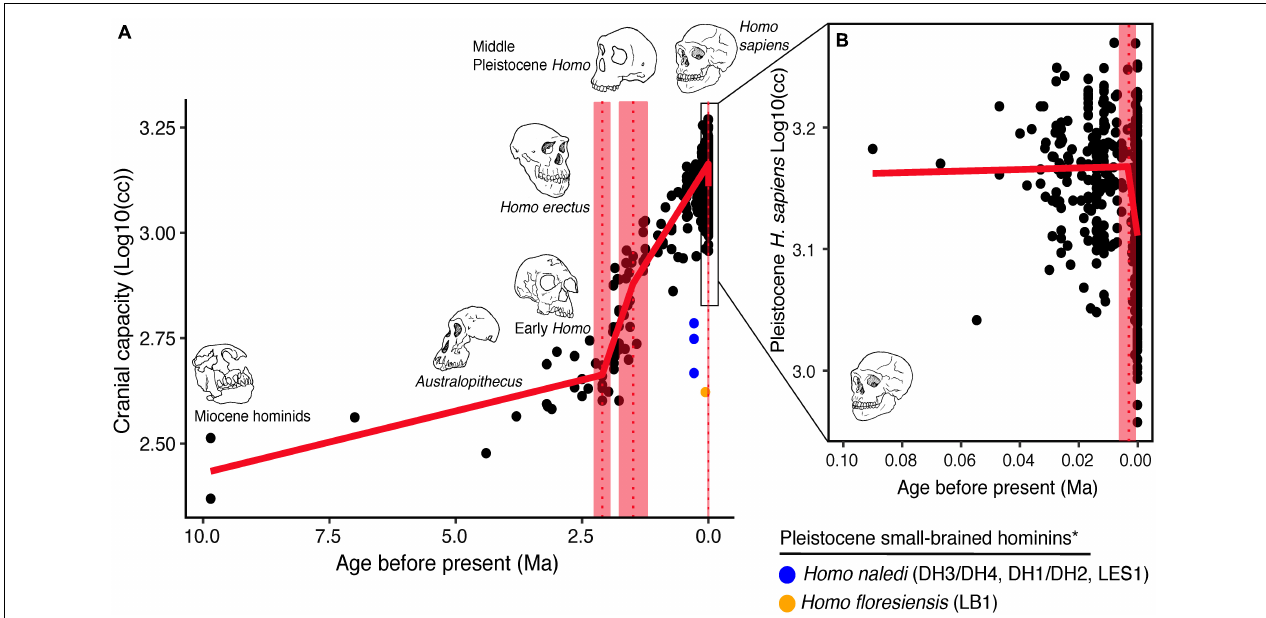
FIGURE 1 | Trends in hominin brain evolution. (A) Cranial capacity in fossil apes (Miocene hominids) and hominins over the last 10 million years. Brain size remained relatively steady throughout the late Miocene and Pliocene, increasing only slightly in Australopithecus compared with earlier hominins. However, by 2 million years ago, there was a dramatic increase in the rate of growth, coinciding with fossil evidence for the earliest members of genus Homo . This change point is illustrated by a red vertical dotted line (95% CI shown as thick pink vertical line). A second change-point is detected at ∼ 1.5 million years ago and the rate of brain size increase remains steady through the Pleistocene and the evolution of Homo sapiens . If the small-brained Middle and Late Pleistocene hominins H. naledi (blue dots) and H. floresiensis (orange dot) are included, these two change points merge into a single, overlapping encephalization event between 1.97 and 2.21 million years ago. (B) During the last 100,000 years, brain size has remained steady in H. sapiens until a rapid and dramatic change point only 3,000 years ago decreased Holocene human brain size at a rate fifty times greater than the previous increases in Pleistocene brain volume. Each black dot represents an individual fossil skull or osteological